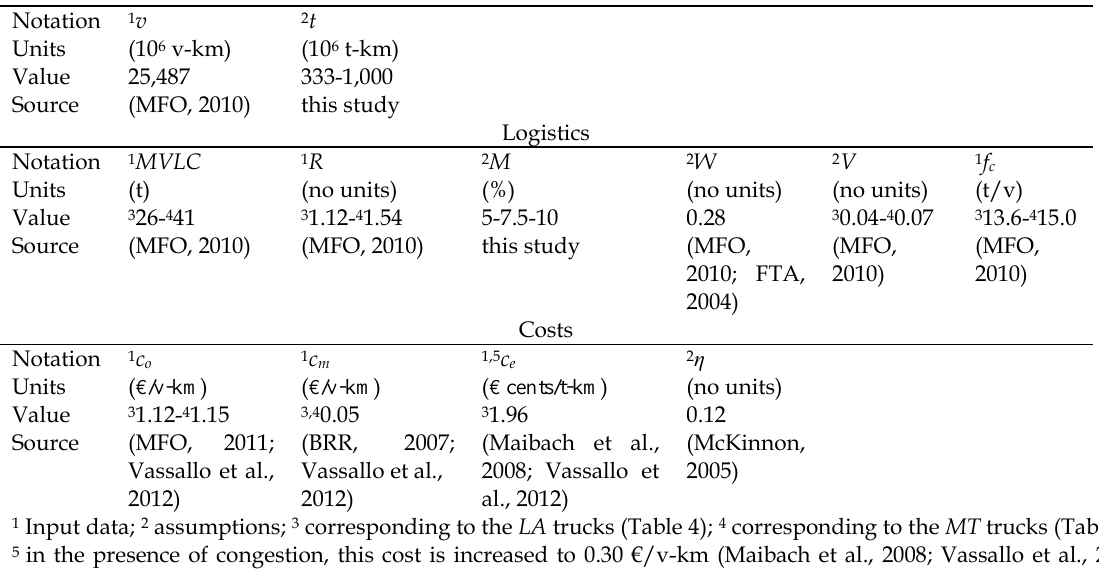
Table 6. Summary table including parameters used in equations